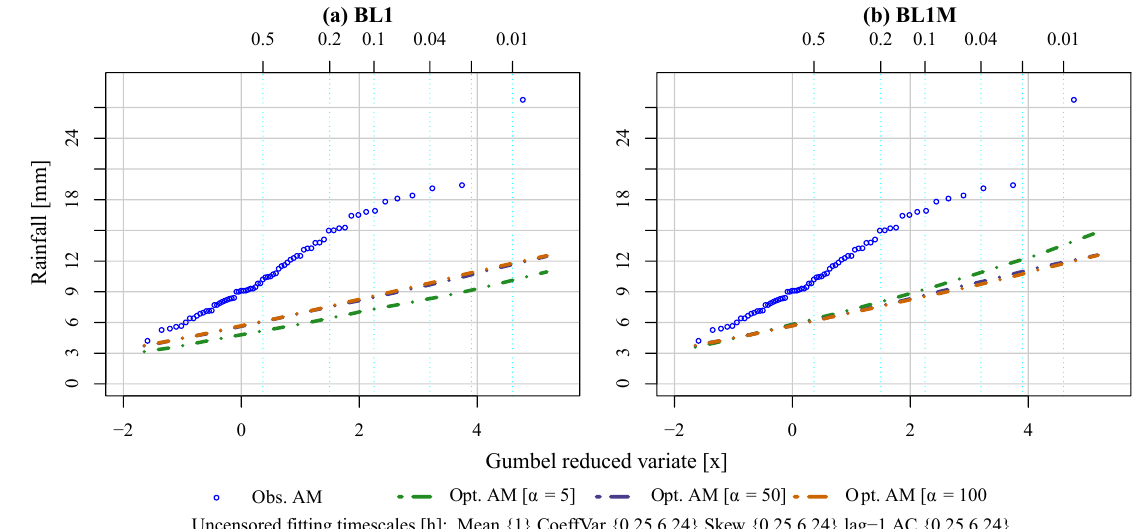
Figure A3. Sensitivity of extreme value estimation to choice of α for the randomized Bartlett–Lewis